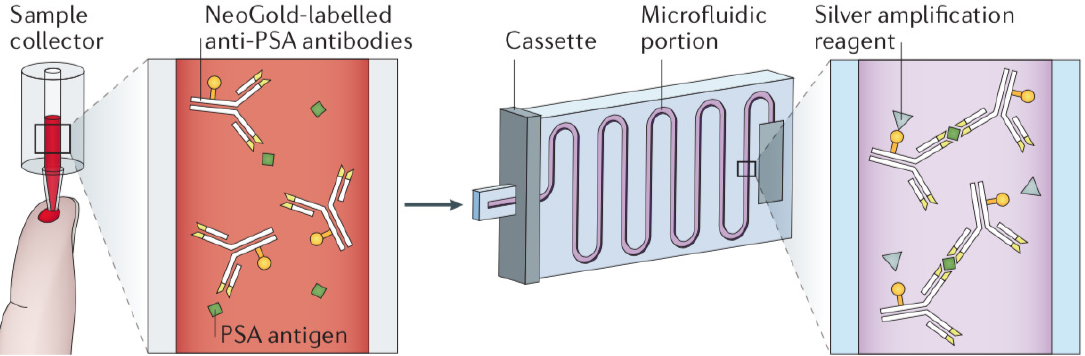
Figure 4. Overview of the microfluidic Sangia technology. From left to right: filling of the sample collector, which contains NeoGold-labeled anti-PSA monoclonal antibodies, and insertion of the sample into the microfluidic channel for silver amplification and